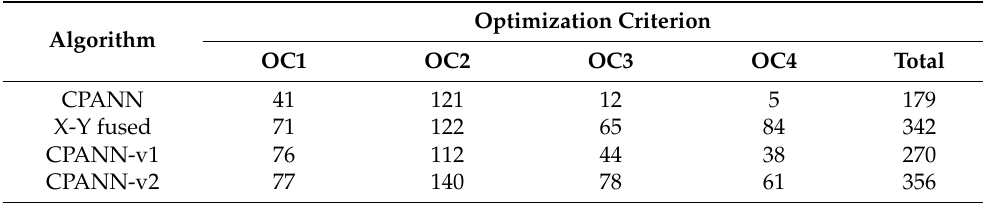
Table 1. Number of selected models obtained when using an initial set of 268 descriptors. Algorithm